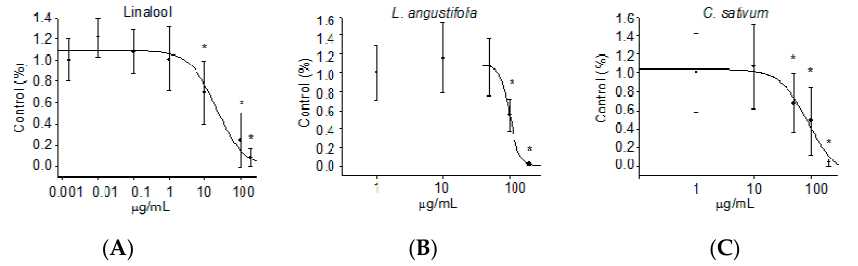
Figure 4. Effects of linalool ( A ); L. angustifolia ( B ); and C. sativum ( C ) essential oils on mean firing rate (MFR) of cortical cultures grown on microelectrode arrays. Each data point is the mean and SEM of 3 independent experiments (* p < 0.05 with respect to the normalised baseline values).